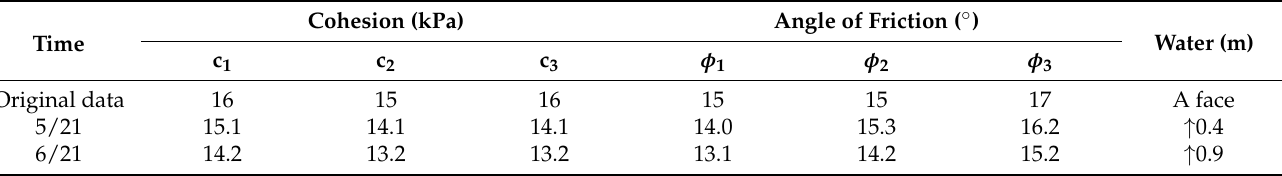
Table 5. Modelling parameters and validation parameters for different stages.